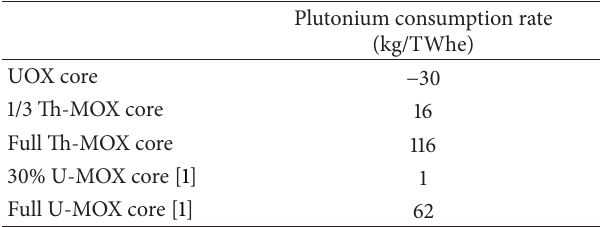
Table 6: The plutonium consumption rate.